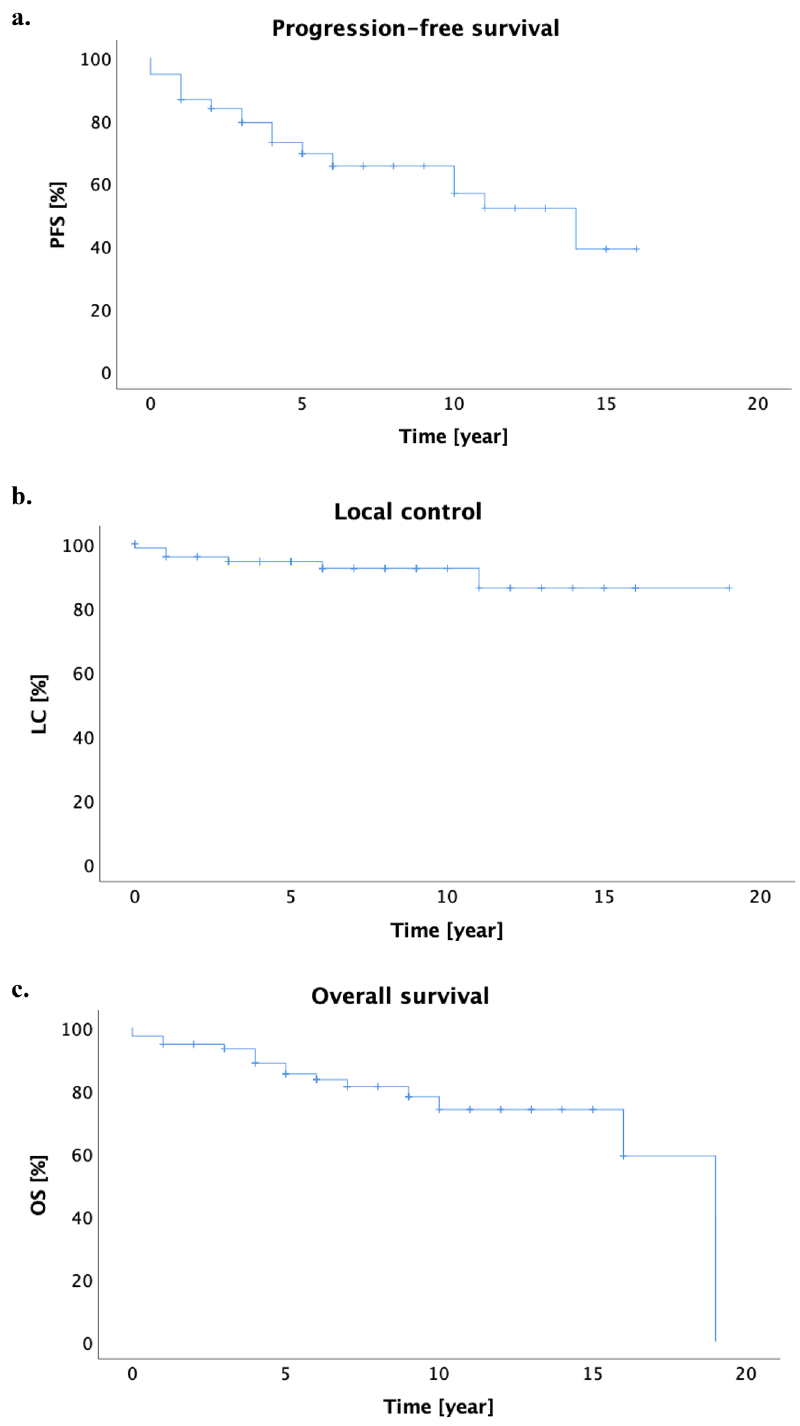
Figure 1. ( a ) The estimated Kaplan–Meier PFS for 5 and 10 years were 73.0% and 65.5% respectively. ( b ) The 5- and 10-year LC was 94.4% and 92.3% respectively. ( c ) The 5- and 10-year OS were 88.6% and